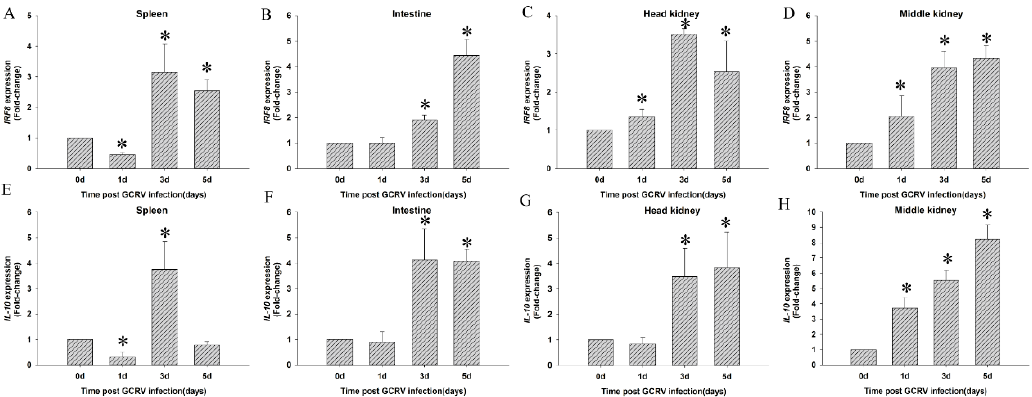
Figure 4. The expression levels of IRF8 ( A – D ) and IL-10 ( E – H ) in four immune tissues (spleen, intestine, head kidney and middle kidney) after GCRV infection. The results are presented as the mean ± SD ( n = 5). The expression level of the control group was set as the baseline (1.0) and were normalized to the expression in the untreated groups (Day 0). * = p ≤ 0.05.